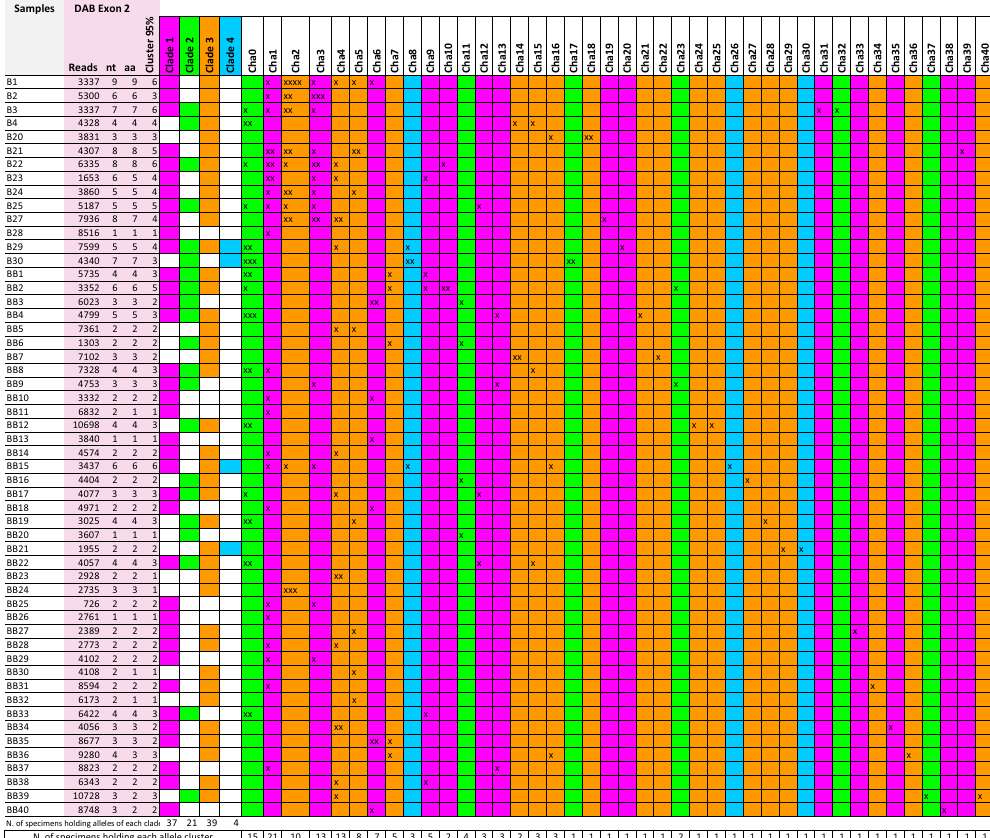
Figure 6. Chionodraco hamatus samples used for the MHC II β analyses with the indication of the corresponding number of reads from the sequencing, of identified peptides (aa), of putative nucleotide sequences (nt) and of clusters grouping sequences differing by less than 3 amino acids out of 68 (95%). The clade membership for each variant is also reported in different colours according to the phylogenetic analyses carried out: purple, clade 1; green, clade 2; orange, clade 3; blue, clade